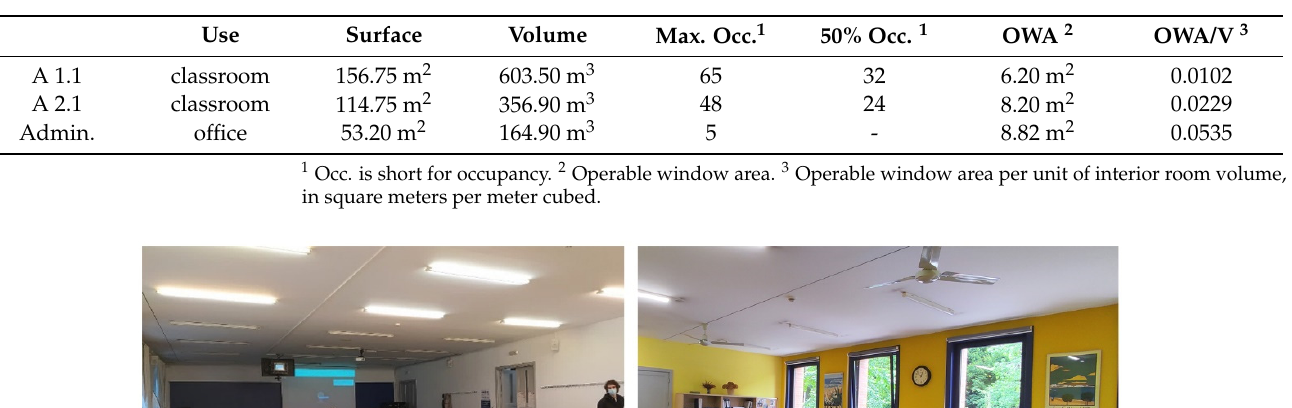
Table 1. Summary of characteristics of the studied rooms.